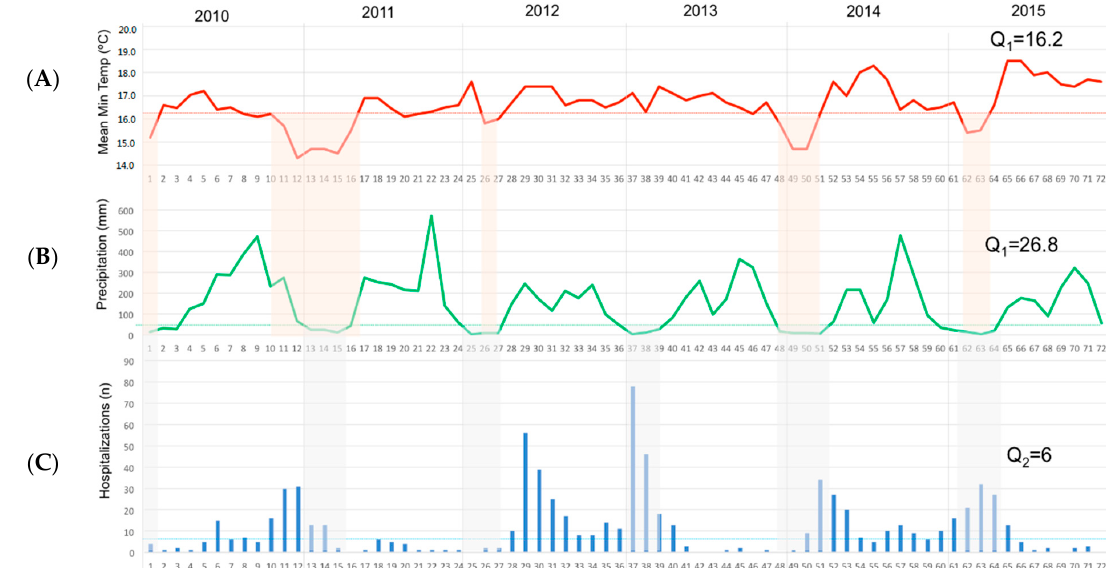
Figure 3. Time series on monthly values of minimum temperature ( A ), cumulative precipitation along with the periods below their 25th percentile values ( B ), and cases of hospital admissions ( C ) in 2010–2015 in the Central Valley of Costa Rica. Quartile 1 level for 25th percentile of minimal temperature (Q 1 = 16.2 ◦ C) is represented as a continuous red line; for 25th percentile of precipitation (Q 1 = 26.8 mm) as a green line, and Quartile 2 level for 50th percentile of monthly cases (Q 2 = 6) as a light blue line.